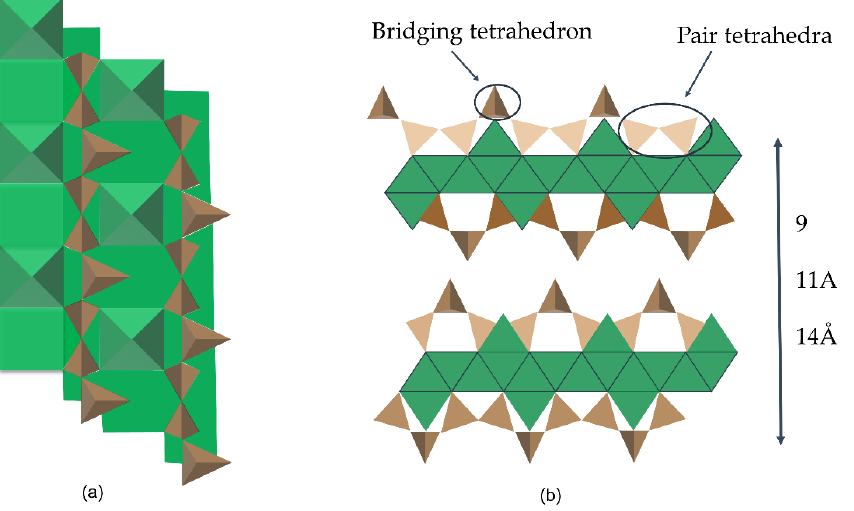
Figure 5. Molecular structure models of tobermorite [86,88]. ( a ): The top view of the silicate chain connected to the calcium sheet in tobermorite structure; ( b ): The side view of the double-layered tobermorite structure without in-terlaminar water molecules and interlaminar calcium ions.